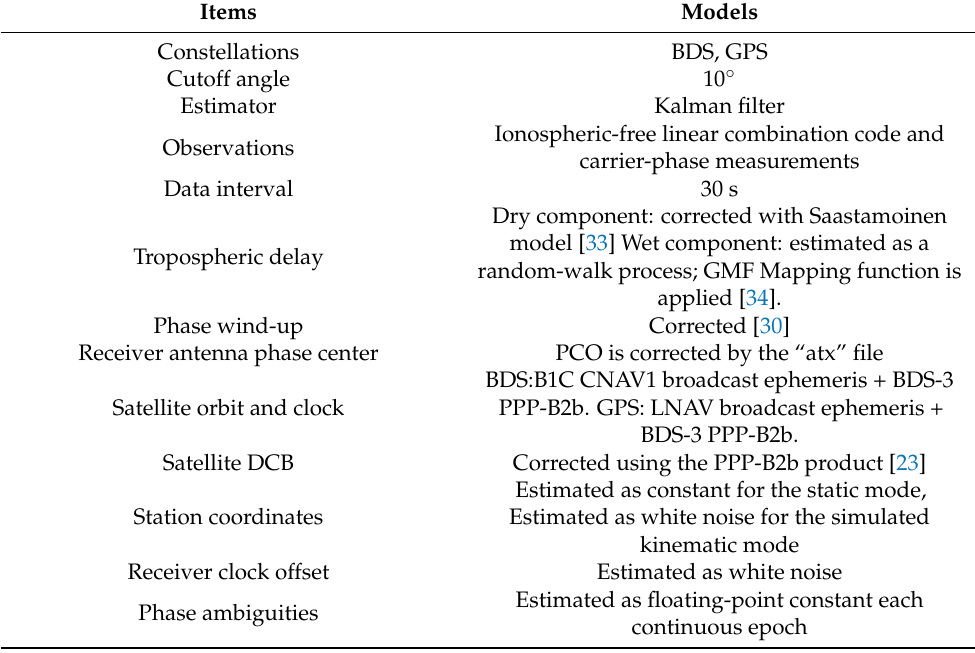
Table 5. Data processing strategies for